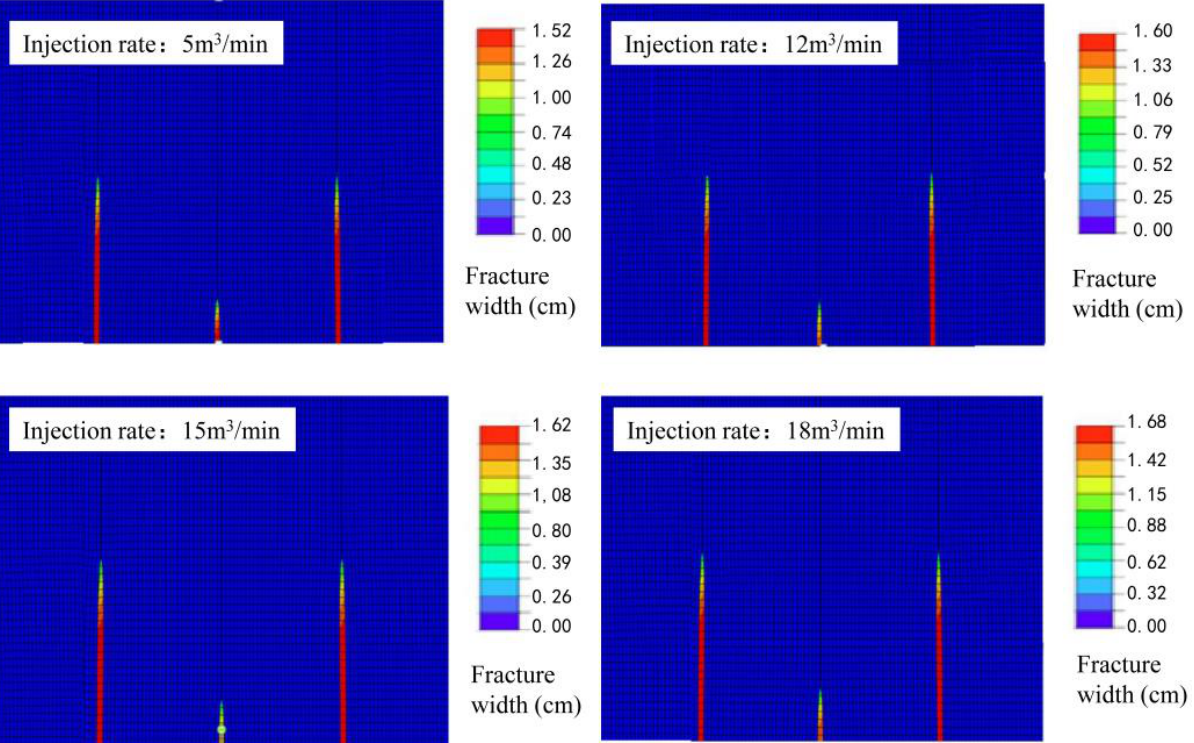
Figure 7: Contour of fracture morphology after fracturing for 10 minutes when the injection rates of fracturing fluid is different. (Deformation scale factor = 500, 30m cluster